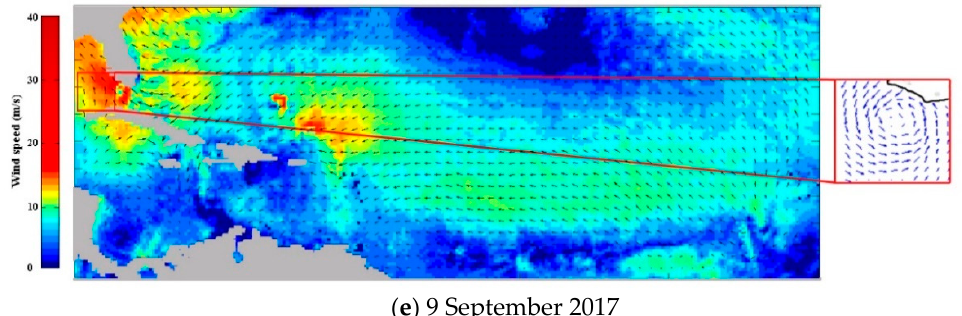
Figure 7. Hurricane Irma tracked by the model: ( a ) appeared as tropical storm and detected by the model; ( b ) developed into tropical hurricane; ( c ) moved westward and approached Puerto Rico; ( d ) landed on Cuba, noting that the cyclone is not detected due to the incomplete wind field; ( e ) turned northward and landed on Florida, U.S. The spatial resolution of the velocity vectors in the insert panel is at 0.25° × 0.25°, while that of the regional vectors is sampled down to 1° × 1°.